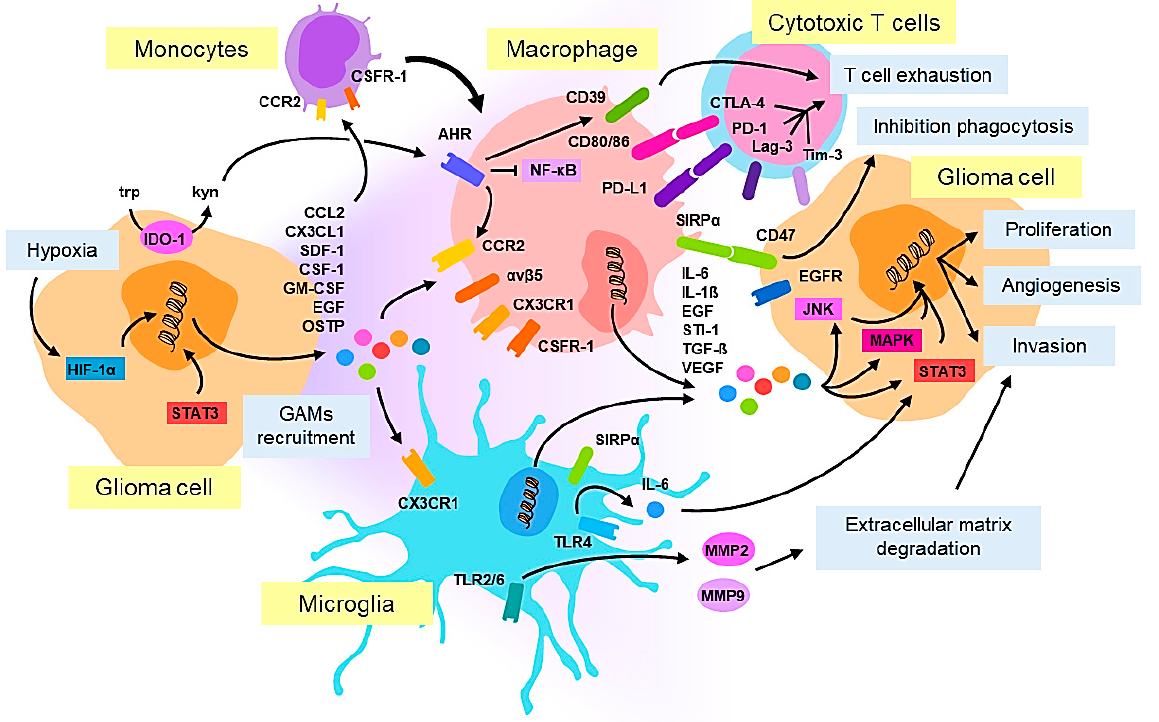
Figure 1. Representation of interactions between glioma cells, macrophages/microglia and other components of the tumor microenvironment. Macrophages and microglia (GAMs) are attracted to the tumor by several glioma cells-derived factors such as CCL2, CX3CL1, SDF-1, CSF-1, GM-CSF, EGF or OSTP, expressed in response to environmental stress (such as hypoxia) or GAMs-derived factors themselves. In the tumor microenvironment, GAMs exert a tumor-supporting activity through secretion of factors such as IL-6 (particularly in response to TLR4 activation in microglia), IL-1 β , EGF, STI-1, TGF- β or VEGF that activate different signaling pathways (such as JNK, MAPK or STAT3 in glioma cells) promoting proliferation, angiogenesis or invasion of tumor cells. In microglia, TLR2/6 activation has been shown to induce MMP2 and MMP9 expression, contributing to extracellular matrix degradation and tumor invasiveness. GAMs are also immunosuppressive effectors, especially via the expression of molecules which lead to T-cell dysfunction (CD80/86, PD-L1 or CD39). The phagocytic activity of GAMs is also impaired by the expression of CD47 (binding to SIRP α ) by glioma cells.